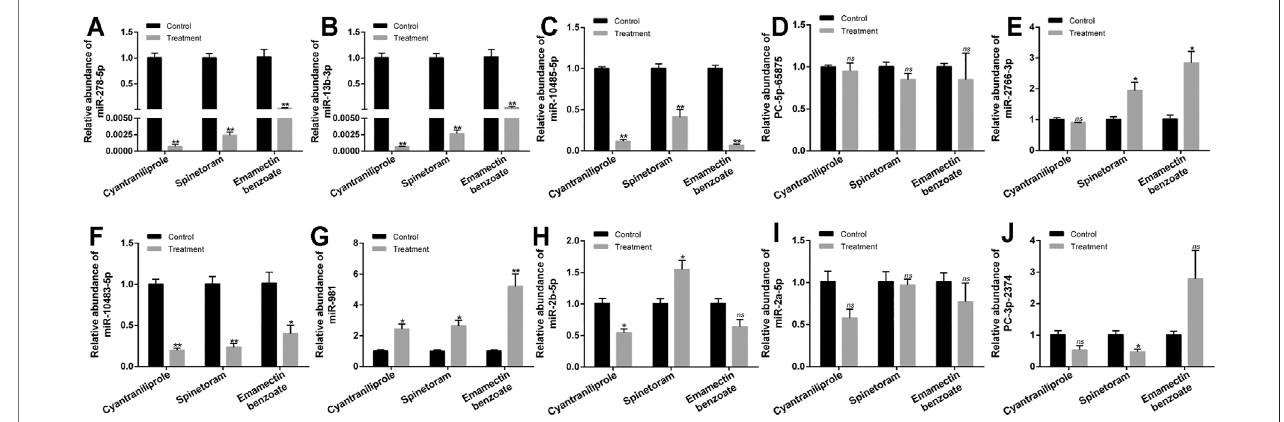
FIGURE 6 | Relative expression of ten miRNAs after the treatments of cyantraniliprole, spinetoram, and emamectin benzoate. (A – J) Relative expressions of miR- 278-5p, miR-13b-3p, miR-10485-5p, PC-5p-65875, miR-2766-3p, miR-10483-5p, miR-981, miR-2b-5p, miR-2a-5p, and PC-3p-2374 after the treatments of cyantraniliprole, spinetoram, and emamectin benzoate. The asterisk (*) and asterisks (**) indicate p < 0.05 and p < 0.01. ns represents no signi fi cant difference. Results are shown as the average ± standard error (SE).